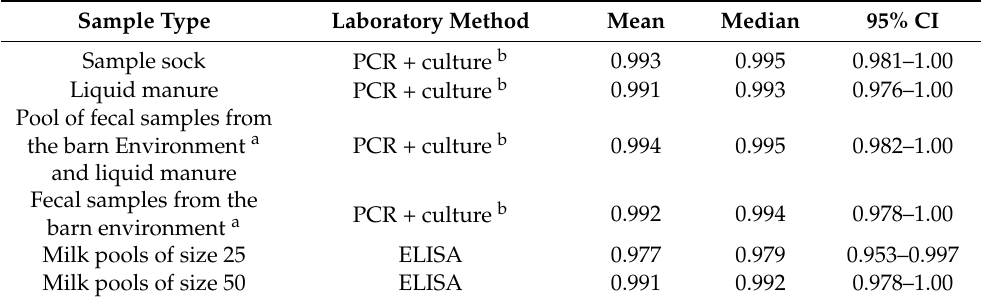
Table 2. Posterior mean, median, and 95% CI of the specificity regarding the detection of MAP at herd level (one sampling event) in large low-prevalence dairy